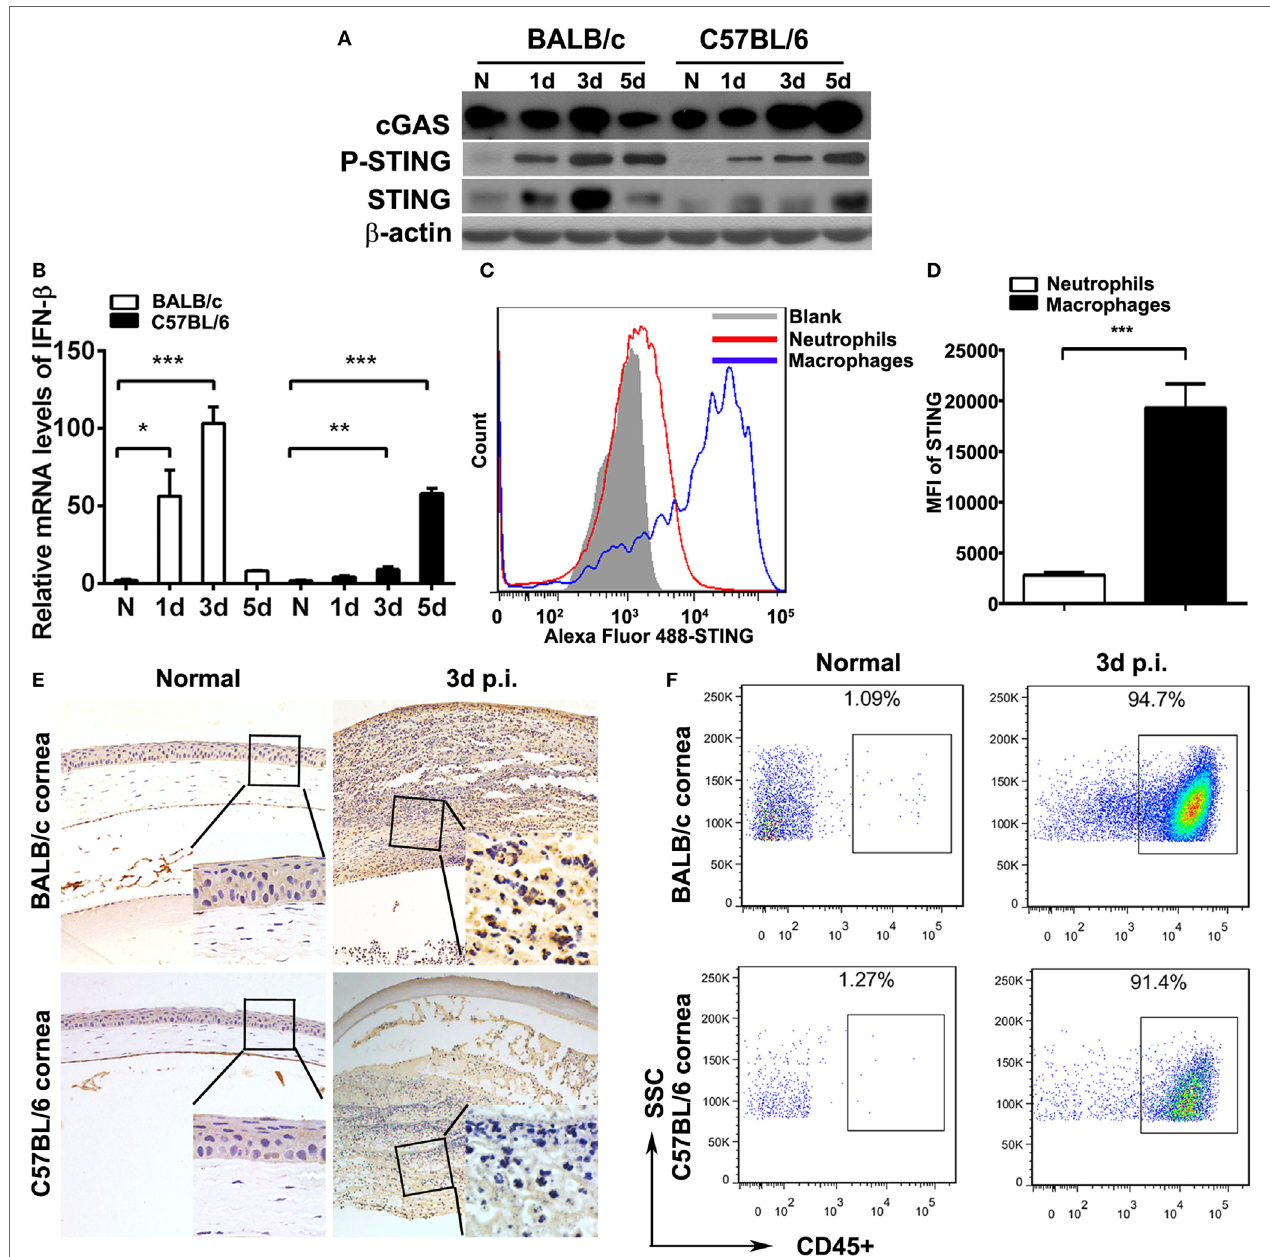
FigUre 1 | Stimulator of interferon genes (STING) expression in mouse corneas. (a) The expression of cyclic GMP-AMP synthase (cGAS), phosphorylated STING (P-STING), and STING was measured by Western blot in normal and infected BALB/c mouse corneas and C57BL/6 mouse corneas at 1, 3, and 5 days postinfection (p.i.). (B) The mRNA levels of IFN- β were measured by real-time PCR in normal and infected BALB/c mouse corneas and C57BL/6 mouse corneas at 1, 3, and 5 days p.i. (c,D) The expression of STING in corneal infiltrating neutrophils (Gr-1 positive) and macrophages (F4/80 positive) was measured by flow cytometry. (e) Immunohistochemical staining was used to detect STING expression in normal and infected BALB/c corneas and C57BL/6 corneas at 3 days p.i. (magnification = × 200). (F) The percentage of infiltrating immune cells in normal and infected BALB/c corneas and C57BL/6 corneas at 3 days p.i. was measured by flow cytometry. All data represent one of three independent experiments each using five pooled corneas per time. MFI, mean fluorescence. * P < 0.05; ** P < 0.01; and *** P <